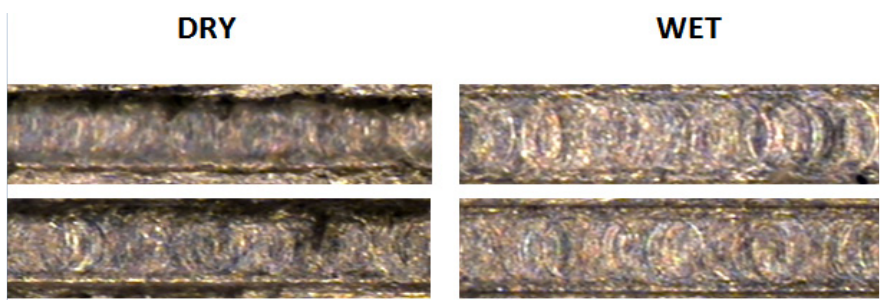
Figure 13. Top view of micro-channel showing roughness optimization by coolant